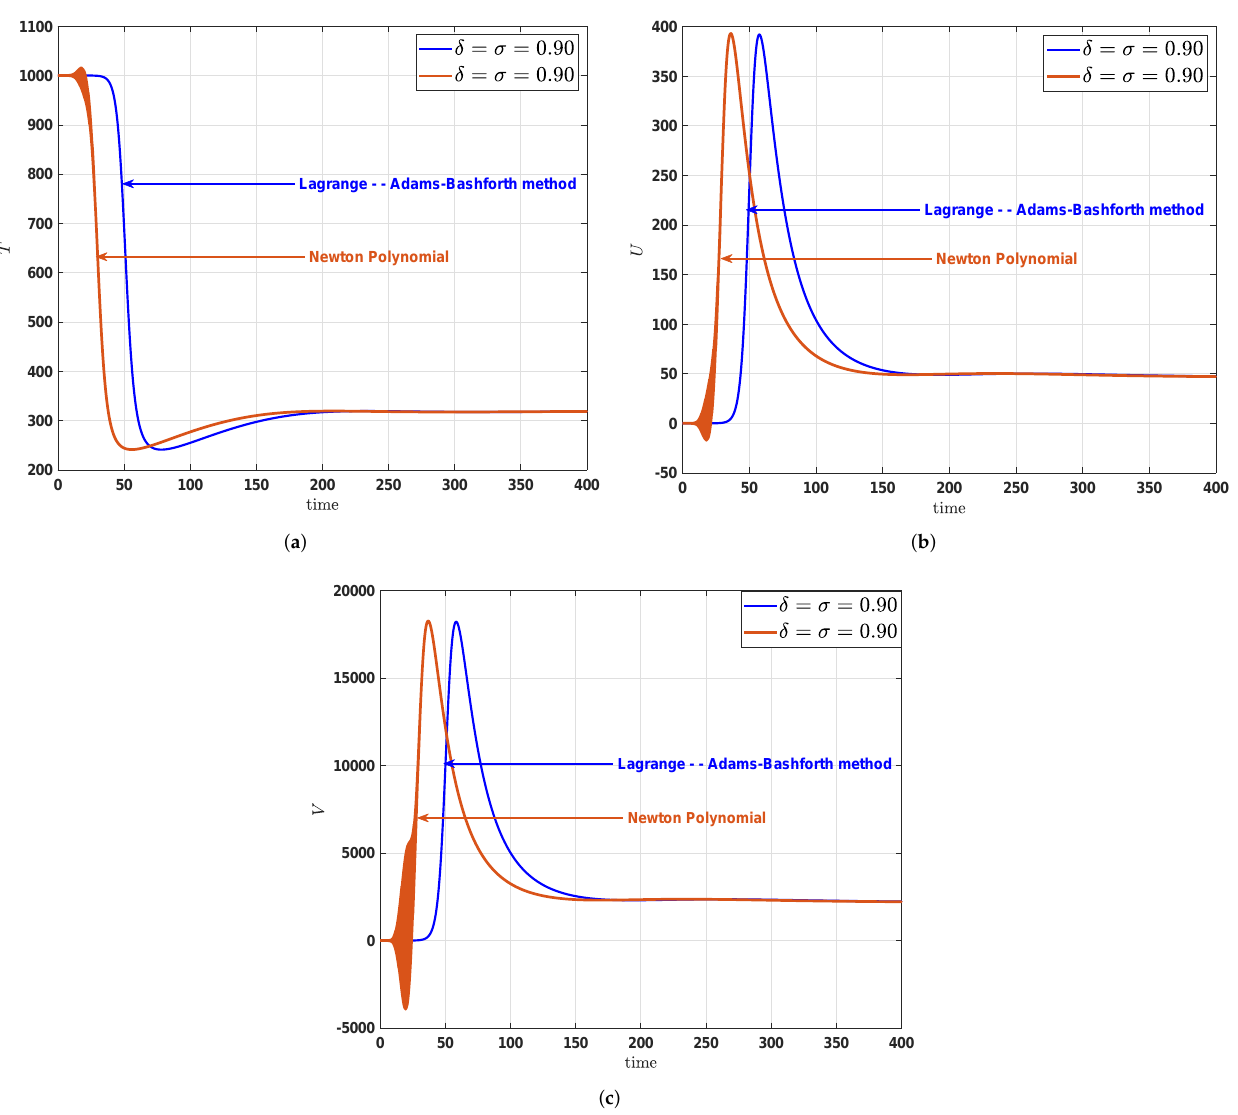
Figure 7. Numerical trajectories in the Comparison of the numerical solutions of the Adams-Bashforth method with Newton polynomials method under the fractal dimension and fractional order δ = σ = 0.90. ( a ) Comparison of the graphs w.r.t. two different numerical algorithms on T . ( b ) Comparison of the graphs w.r.t. two different numerical algorithms on U . ( c ) Comparison of the graphs w.r.t. two different numerical algorithms on V .